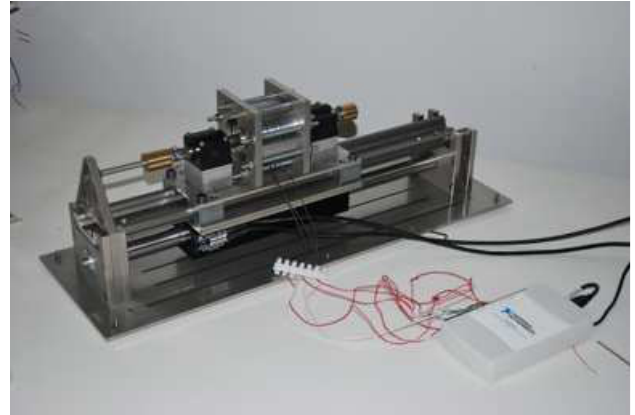
Figure 9. Experimental prototype test